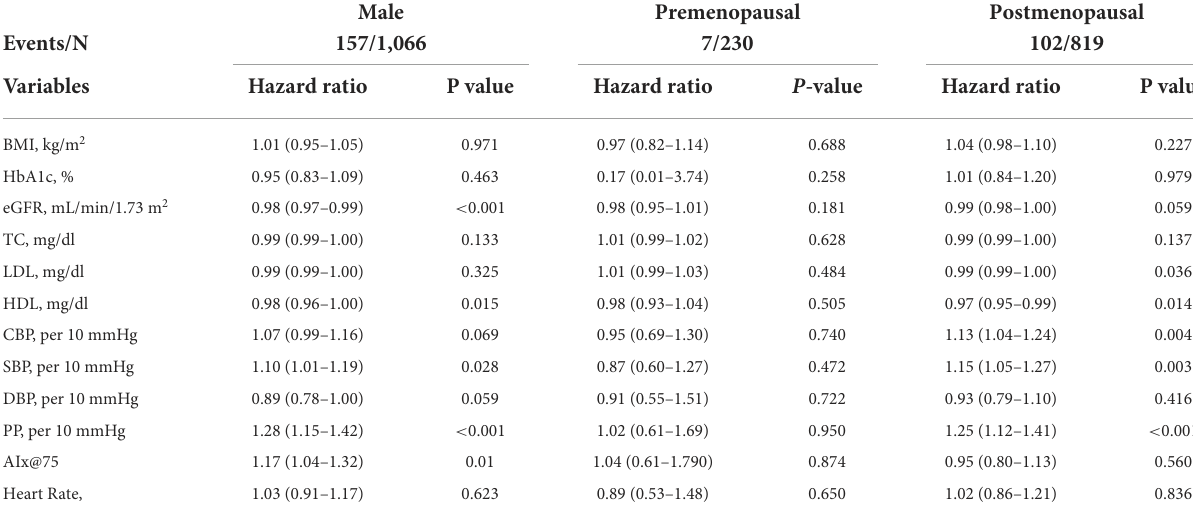
TABLE 2 Univariate Cox proportional hazards model.